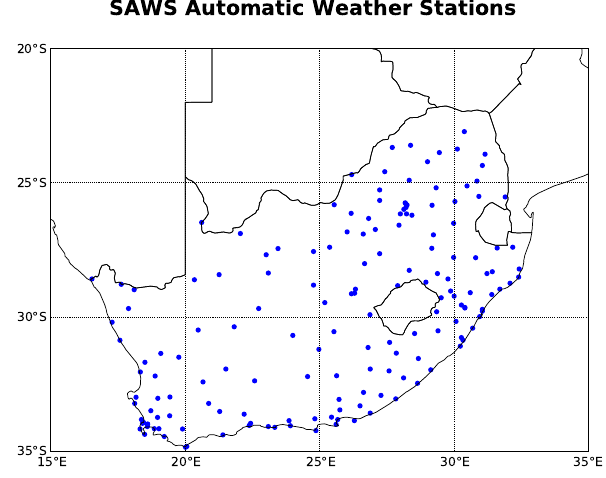
Fig. 1. Plot showing the locations of the South African Weather Services (SAWS) current automatic weather stations. Other mete- orological stations exist, but are either manually read, or are oper- ated by different organizations. The coverage is sparse, with only 164stations in 1.2millionkm 2 .